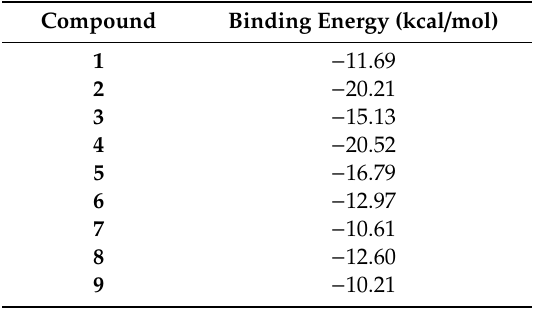
Table 5. Binding energies calculated for the compounds after 100 ns molecular dynamic simulation.